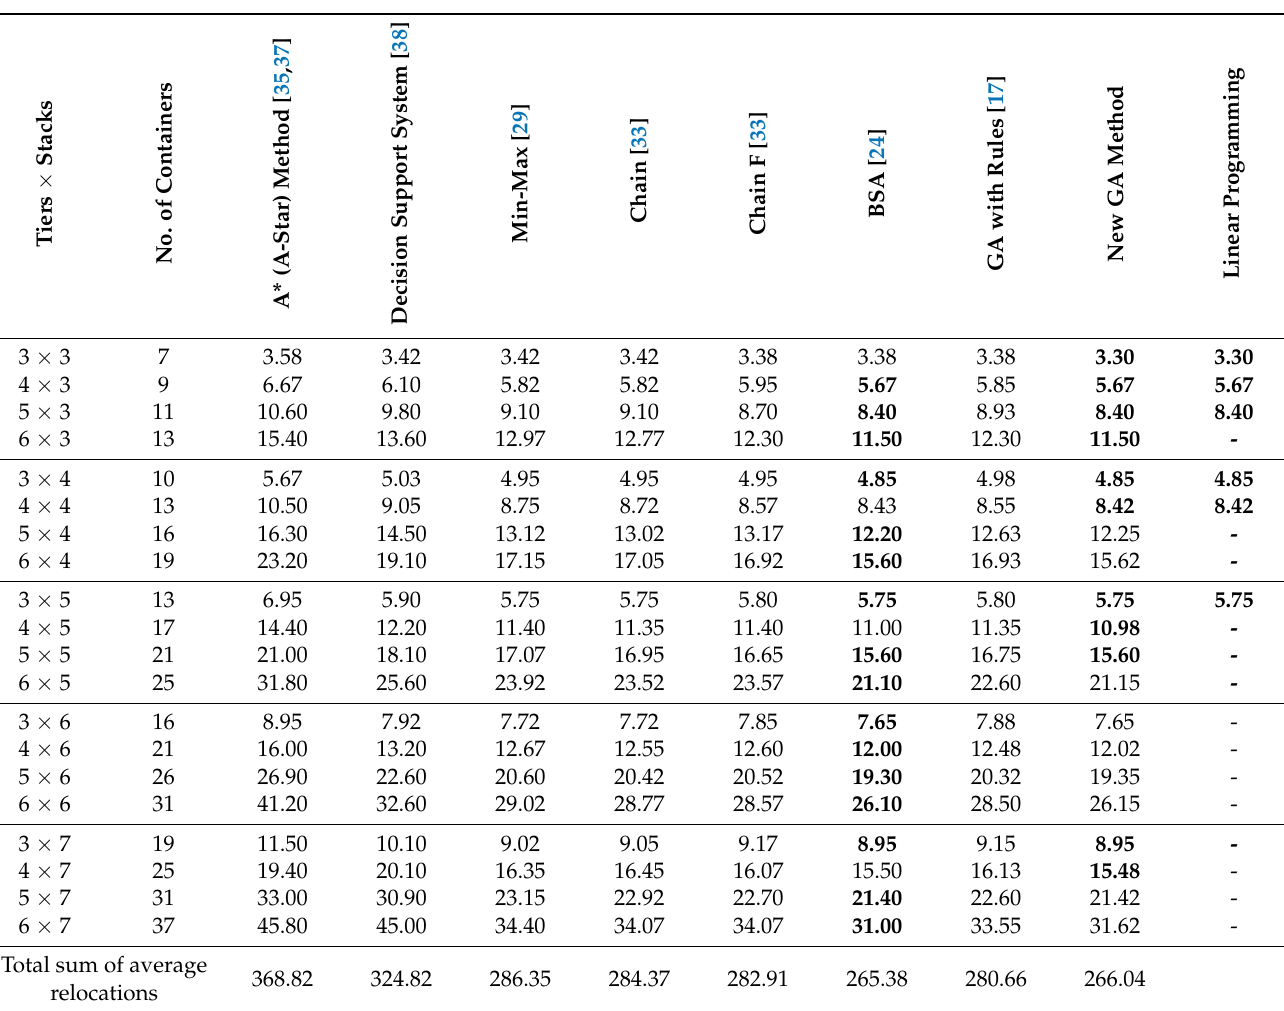
Table 2. The results of the CRP test set [24] on real sizes of bays achieved by the proposed method and the other best models of different